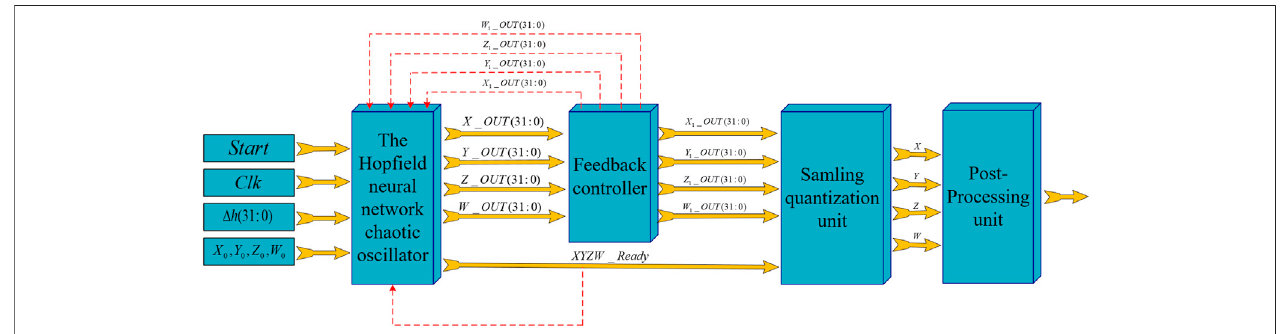
FIGURE 8 | The structure of